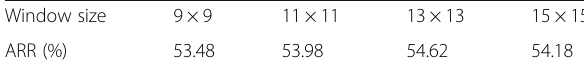
window sizes on UIUC database